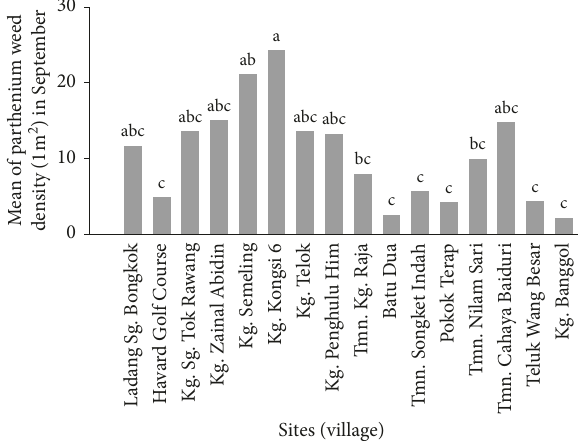
Figure 5: Parthenium weed density at different villages of Kuala Muda, Kedah, in September 2015. Kg. � Kampung, Tmn. � Taman, and Sg. � Sungai. Dissimilar small letters on bars indicate a sig- nificant